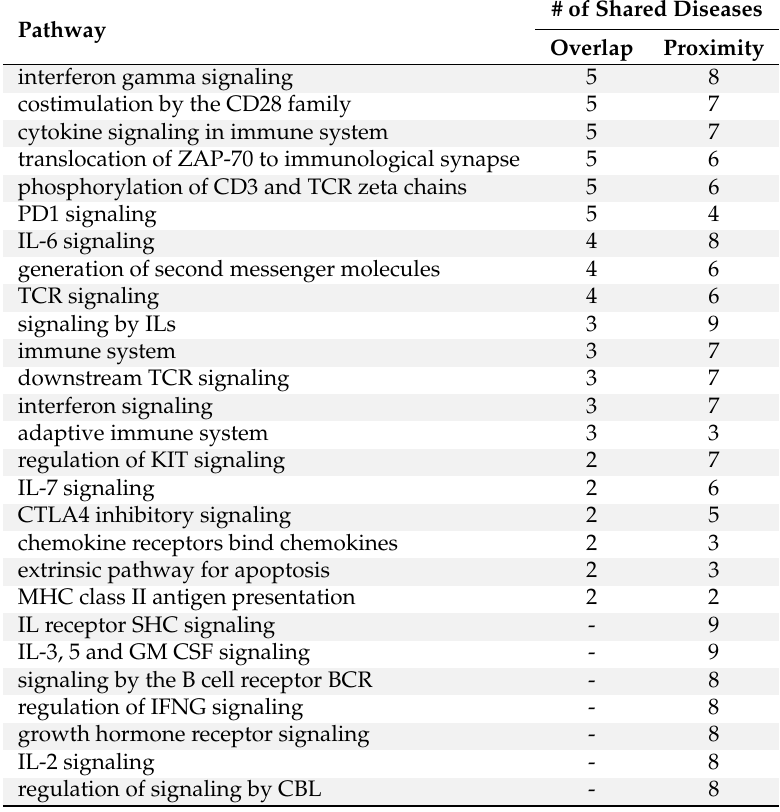
Table 2. Pathways shared by autoimmune disorders based on the overlap and proximity of genes (only pathways that appear most commonly across diseases are